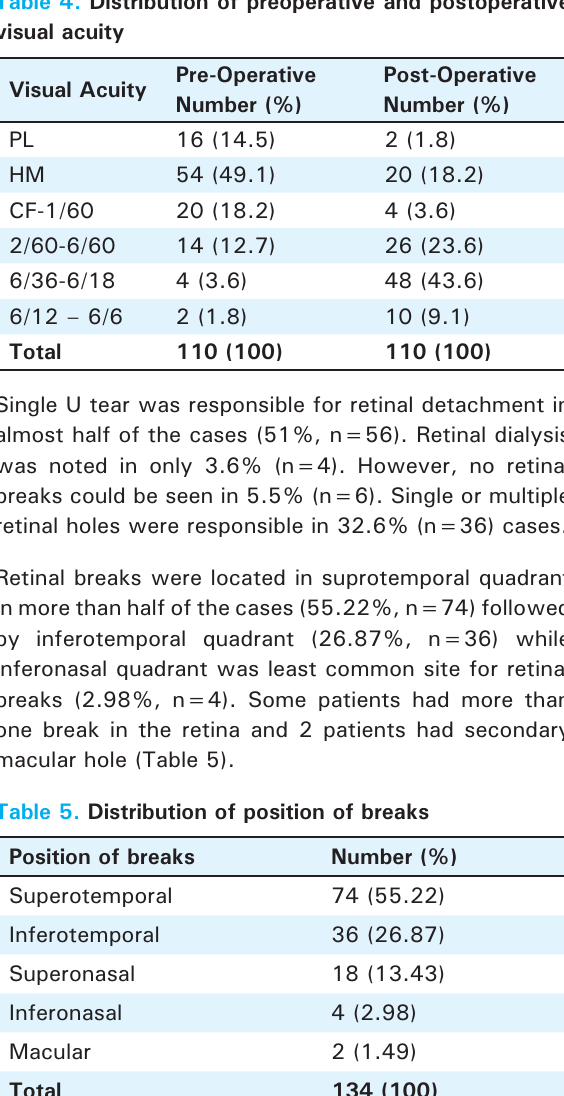
Table 4. Distribution of preoperative and postoperative